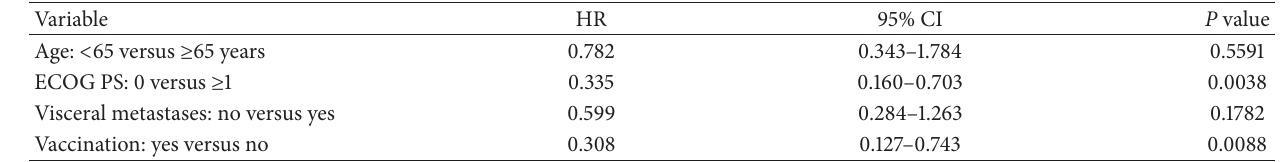
Table 5: Multivariate proportional hazards regression model for overall survival.